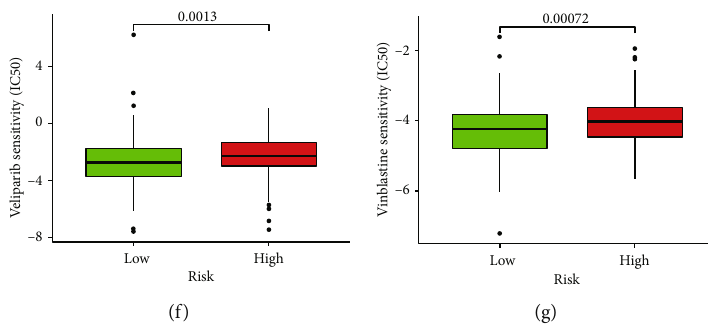
Figure 10: Drug sensitivity analysis of independent prognostic genes. (a) Four independent prognostic genes and drug sensitivity (measured by Z -score) were analyzed by Pearson ’ s correlation analysis. The top 16 associations were shown, ordered by p value ( ∣ Pearson ’ scorrelation ∣ >0 : 25 and p < 0 : 05 ). (b – g) The signi fi cance of the di ff erence in IC50 scores between high-risk and low-risk groups for 6 drugs, including cisplatin, docetaxel, gemcitabine, paclitaxel, veliparib, and vinblastine, was analyzed by Wilcoxon ’ s